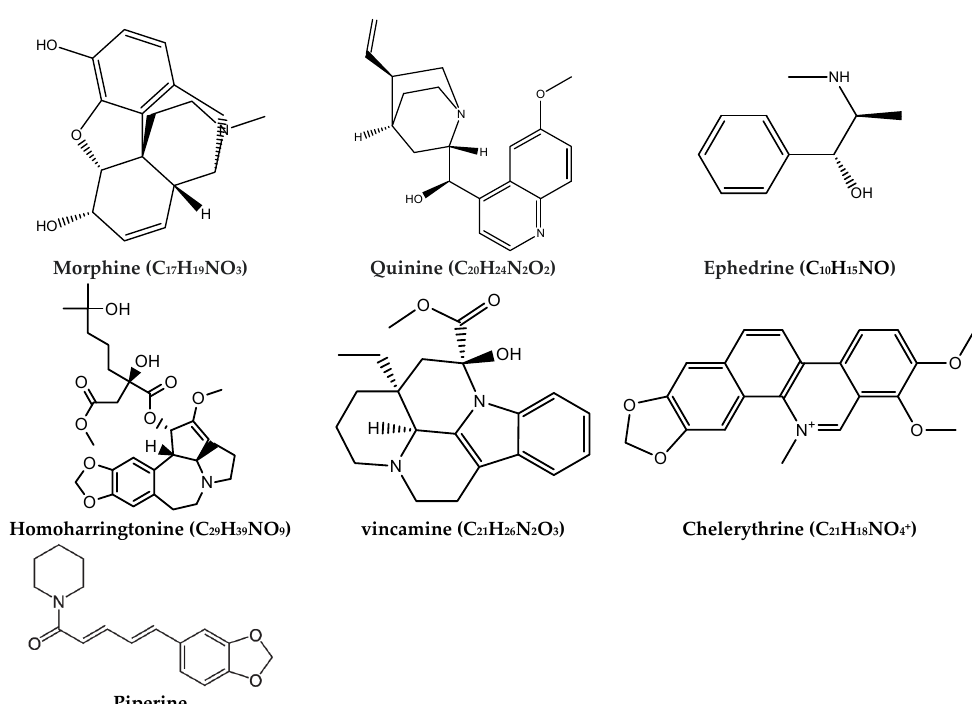
Figure 3. Chemical structures of some common plant alkaloids.